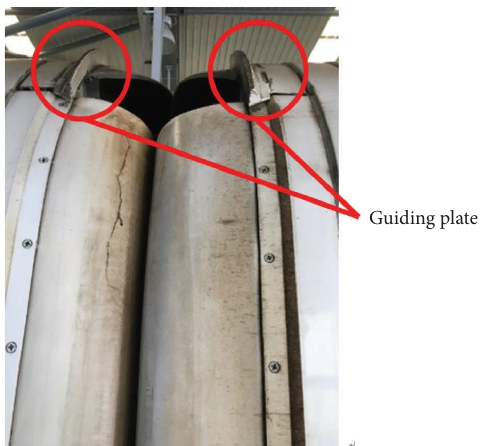
Figure 7: Specifc scheme of car body end wall optimization.